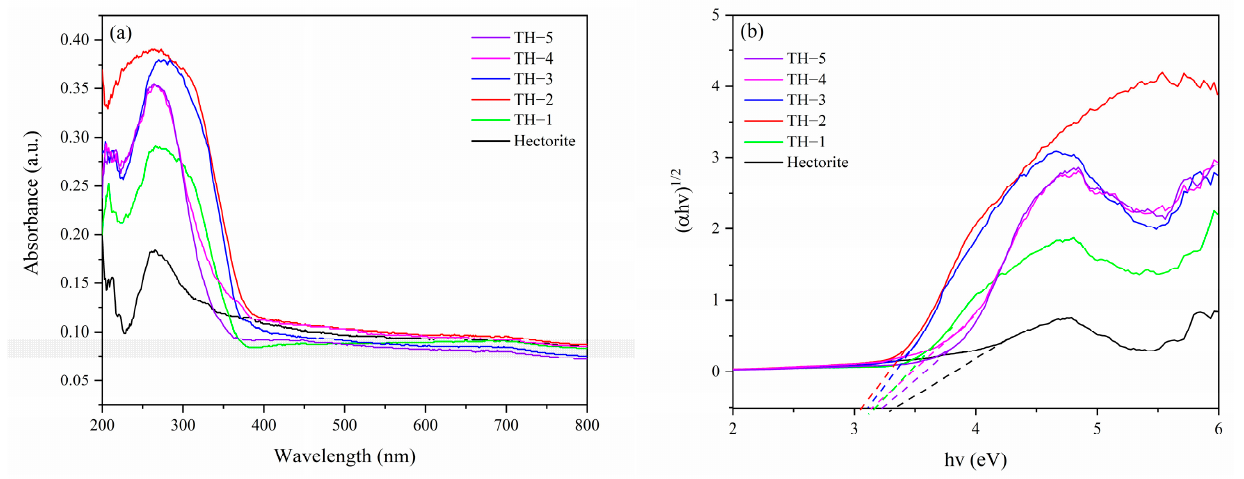
Figure 6. UV-Vis diffuse reflectance spectra and band gaps: ( a) reflectance spectra and ( b ) band gaps.